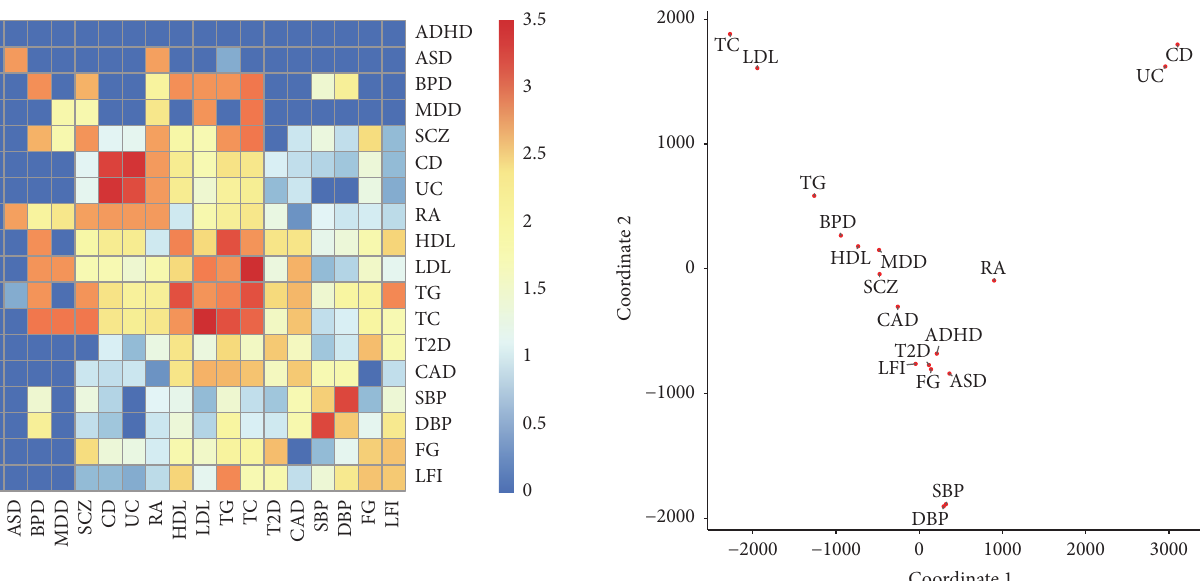
Figure 5: Heat map of shared risk SNPs for 18 phenotypes. Here, “risk SNPs” were determined using the GPA algorithm by control- ling the global FDR at 0.1. Then, values were log 10 -transformed for the visualization purpose.